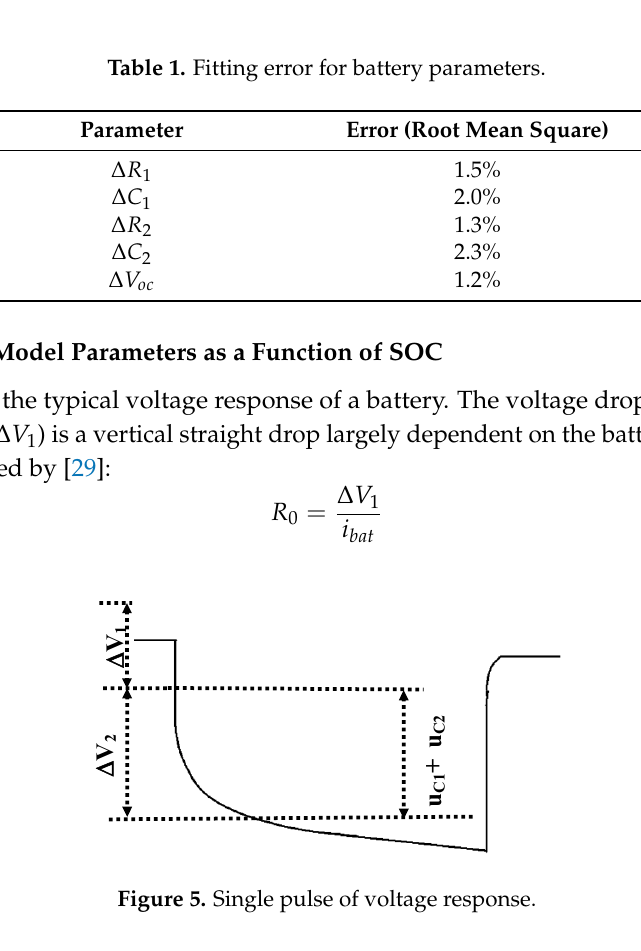
(b) Figure 6. Values of activation parameters versus SOC for different discharge currents ( a ) resistance (cid:1844) (cid:2869) ( b ) capacitance (cid:1829) (cid:2869) .